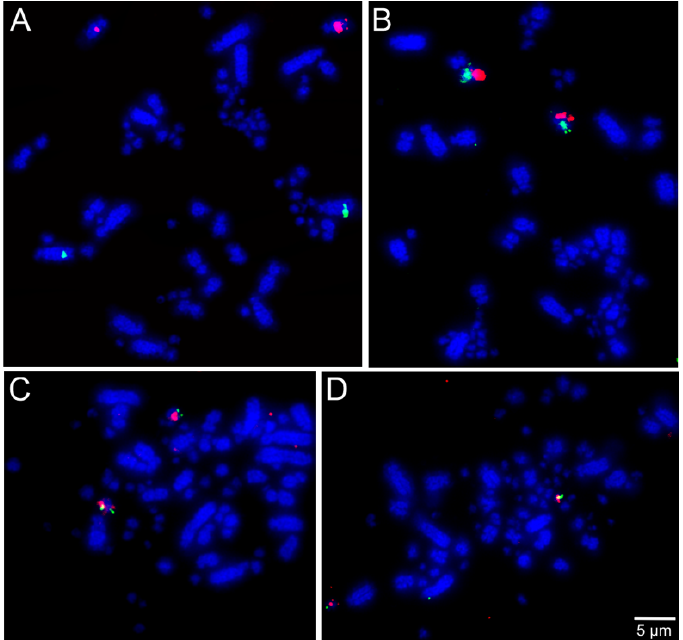
Figure 3. Examples of FISH experiments using chicken or zebra finch BAC probes in Hydropsalis torquata : ( A ) chicken macrochromosome 2 CH261-44D16 FITC and CH261-177K1 Texas red; ( B ) chicken macrochromosome 9 CH261-183N19 FITC and chicken microchromosome 13 TGMCBA- 321B13 Texas red; ( C ) chicken microchromosome 12 CH261-60P3 FITC and CH261-4M5 Texas red; and ( D ) chicken microchromosome 27 CH261-66M16 FITC and CH261-28L10 Texas red.